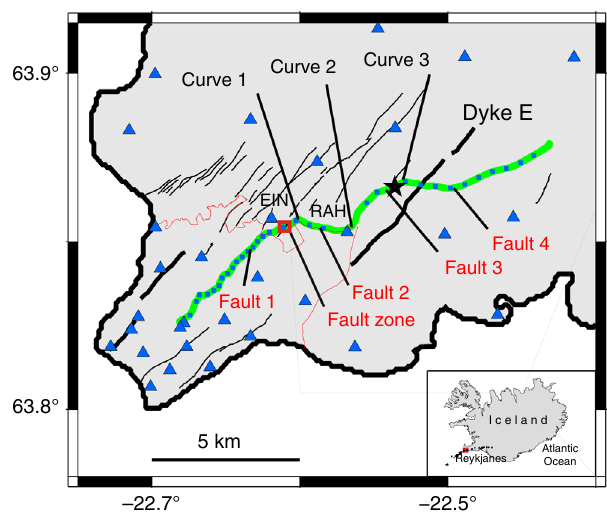
Fig. 1 Location of the fi bre-optic cable in Reykjanes and main geological features 70 . Location of the fi bre-optic cable (continuous green line) from the telecommunication network (Míla Company) used for our measurements within the Reykjanes fi ssure swarm (black lines). Small light blue squares along the fi bre-optic cable represent geophones. Blue triangles indicate broadband seismological stations from the European Project IMAGE (Integrated Methods for Advanced Geothermal Exploration) network 41,44 . RAH and EIN are the closest broadband stations to the optical cable. The thick black lines indicate a series of cones and postglacial craters, from the latest eruptive episode in Reykjanes in 1210 – 1240 (e.g. Dyke E = Eldvörp crater row). The black star indicates a local earthquake epicentre (depth ~3.5 km). The thin red curve indicates the limit of the Sh = Sandfellshæð lava shield (most recent lava fl ow), hiding most of the faults at the surface of the tip of the Peninsula. The inset represents the location of the area in Iceland (North Atlantic), with black dots being epicentres of 68 earthquakes (Supplementary Table 1) recorded during the 9 days of